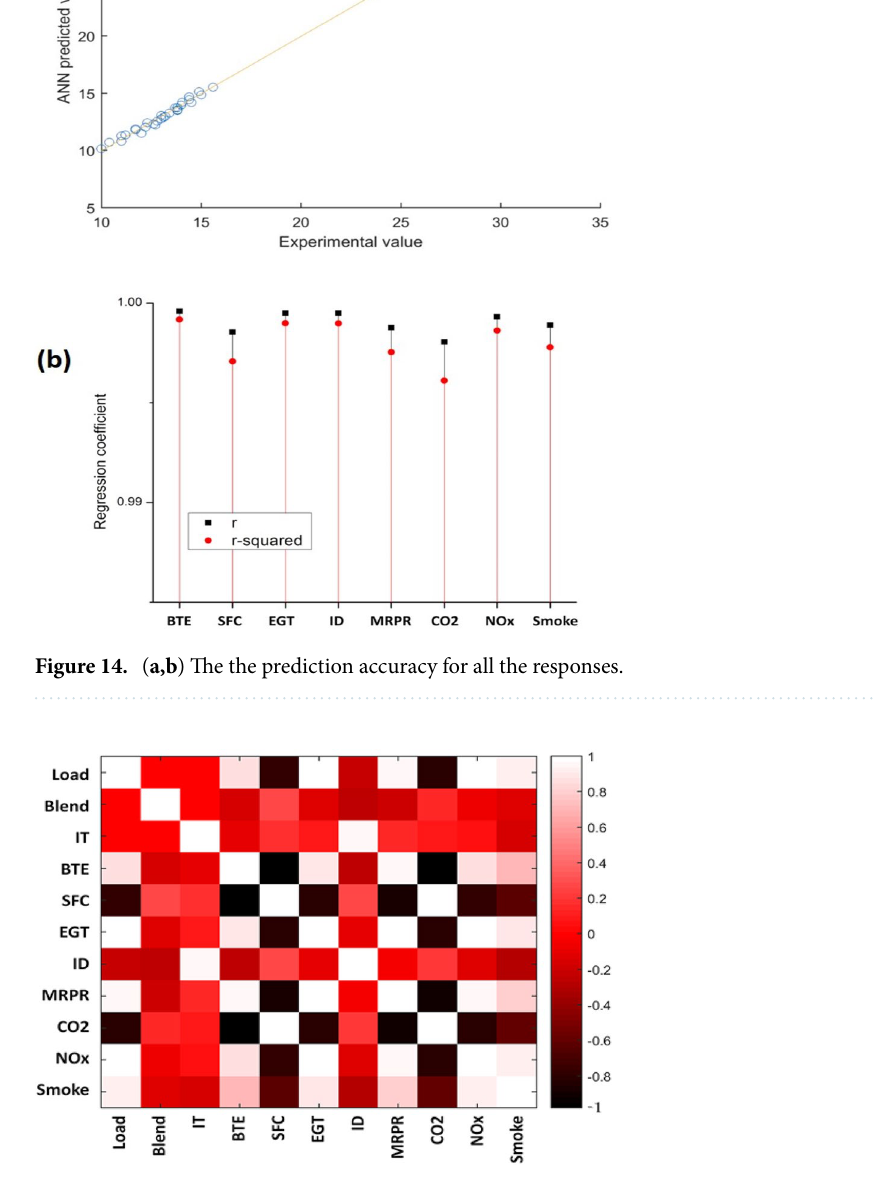
Figure 15. despite the non-linearity in the reported